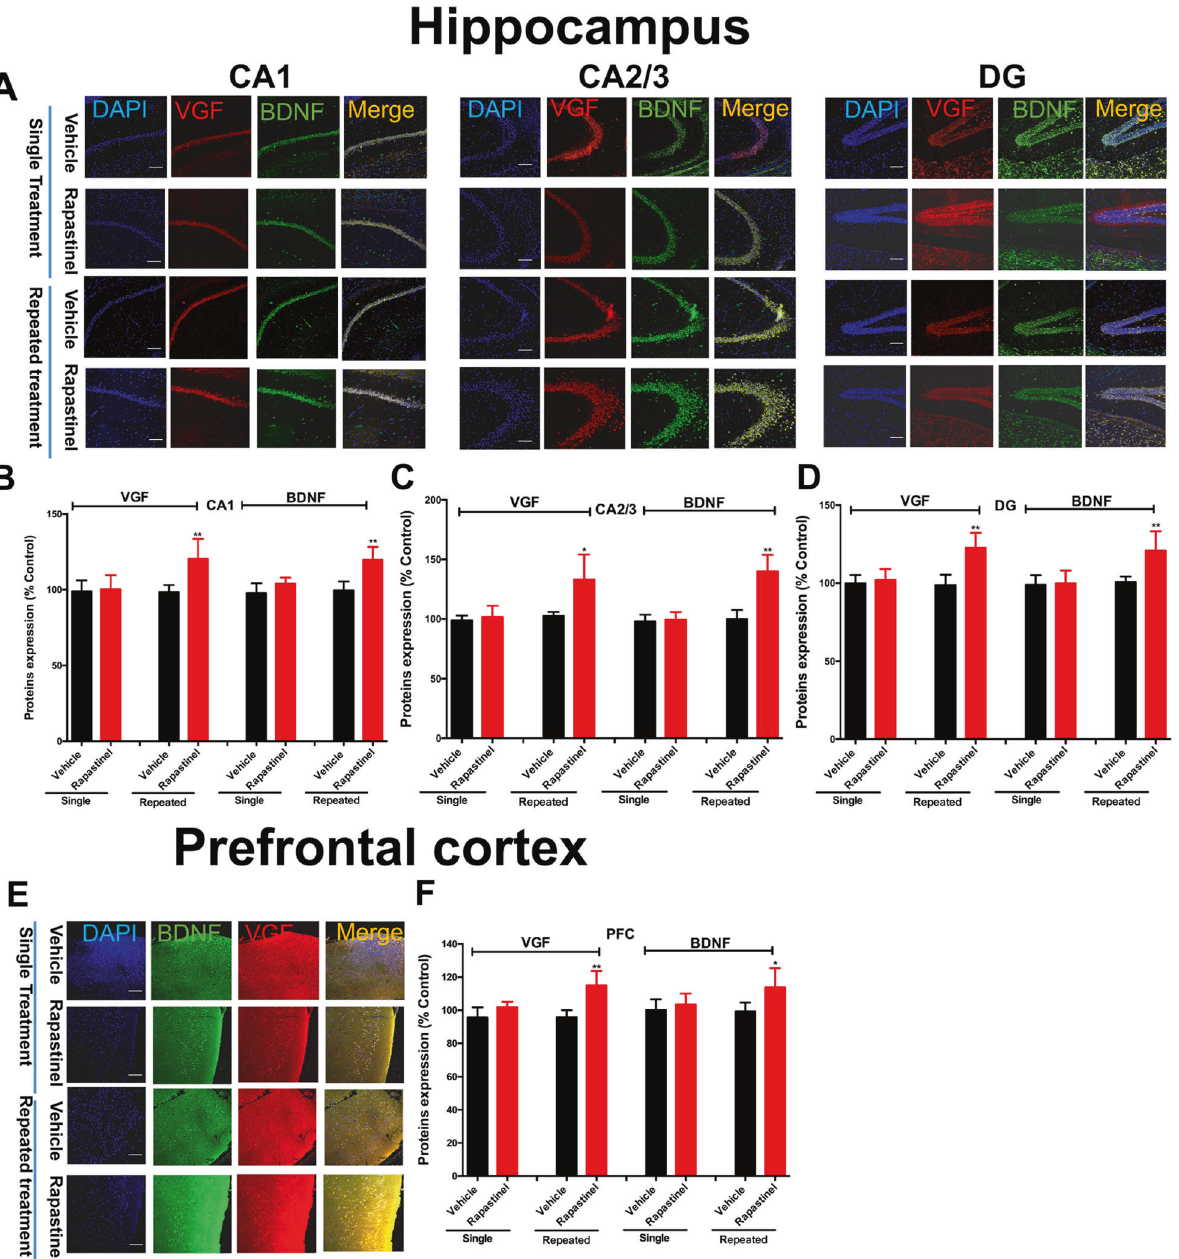
Fig. 2 Repeated treatment with rapastinel upregulates the expressions of BDNF and VGF in the hippocampus and PFC of mice. Immuno fl uorescent images of BDNF and VGF in the CA1, CA2/3, and DG subregions of the hippocampus ( A ) and PFC ( E ) in mice. Quanti fi cation of BDNF and VGF expression in the CA1, CA2/3, and DG subregions of the hippocampus ( B , C , and D ) and PFC ( F ) in mice. Repeated treatment with rapastinel produced long-lasting upregulation of the expression of BDNF (green) with VGF (red) in the hippocampal and PFC neurons in mice. Scale bar = 200 μ m. Data are expressed as means ± S.E.M; n = 5 per group. * P < 0.05, ** P < 0.01 compared with vehicle